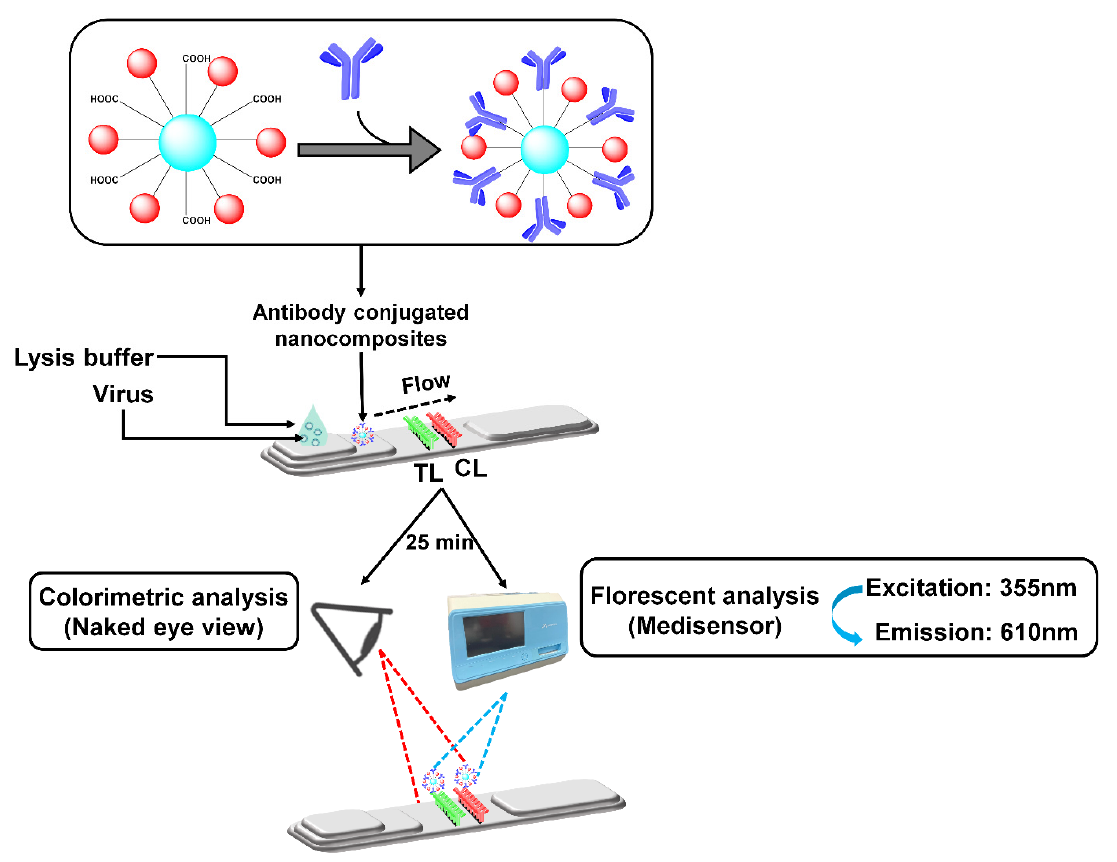
The antibody conjugation of the Cys Au-EuNPs was tested using RDT and FICT assays, with the images obtained by the naked eye and medisensor analysis, respectively (Figure 6). To achieve this, the RDT and FICT assays and nanoparticles conjugates were loaded onto a conjugation pad and dried for 15 min at 37 ◦ C. A lack of reaction between the conjugated material and the monoclonal antibody (mAb) on the TL (test line) indicates the absence of the virus, whereas a reaction indicates that the virus is present. The CL (control line) strips were coated with anti-mouse IgG, which recognizes the sample virus NP antibody (Ab) in the conjugates. Thus, the LFIA kits were used as the tests. Both the colorimetric and fluorescence signals were noted within 25 min of placing the virus sample onto the strip. The TL/CL values indicate the amount of virus in the sample. A comparison of the RDT and FICT was achieved, using commercial AuNPs and EuNPs conjugates as a positive control.